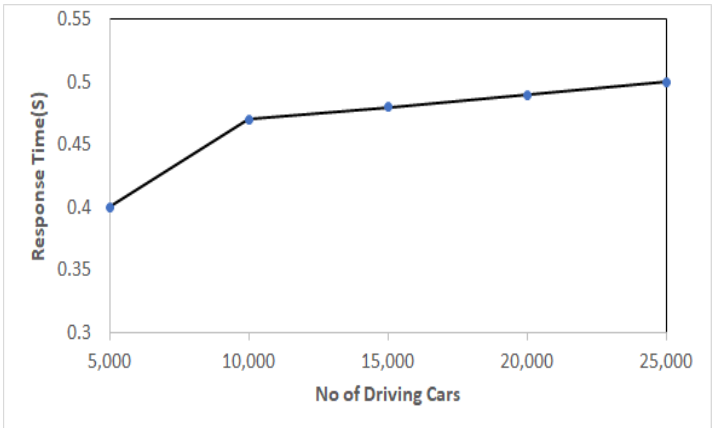
Figure 16. Effects of varying the number of driving cars on response